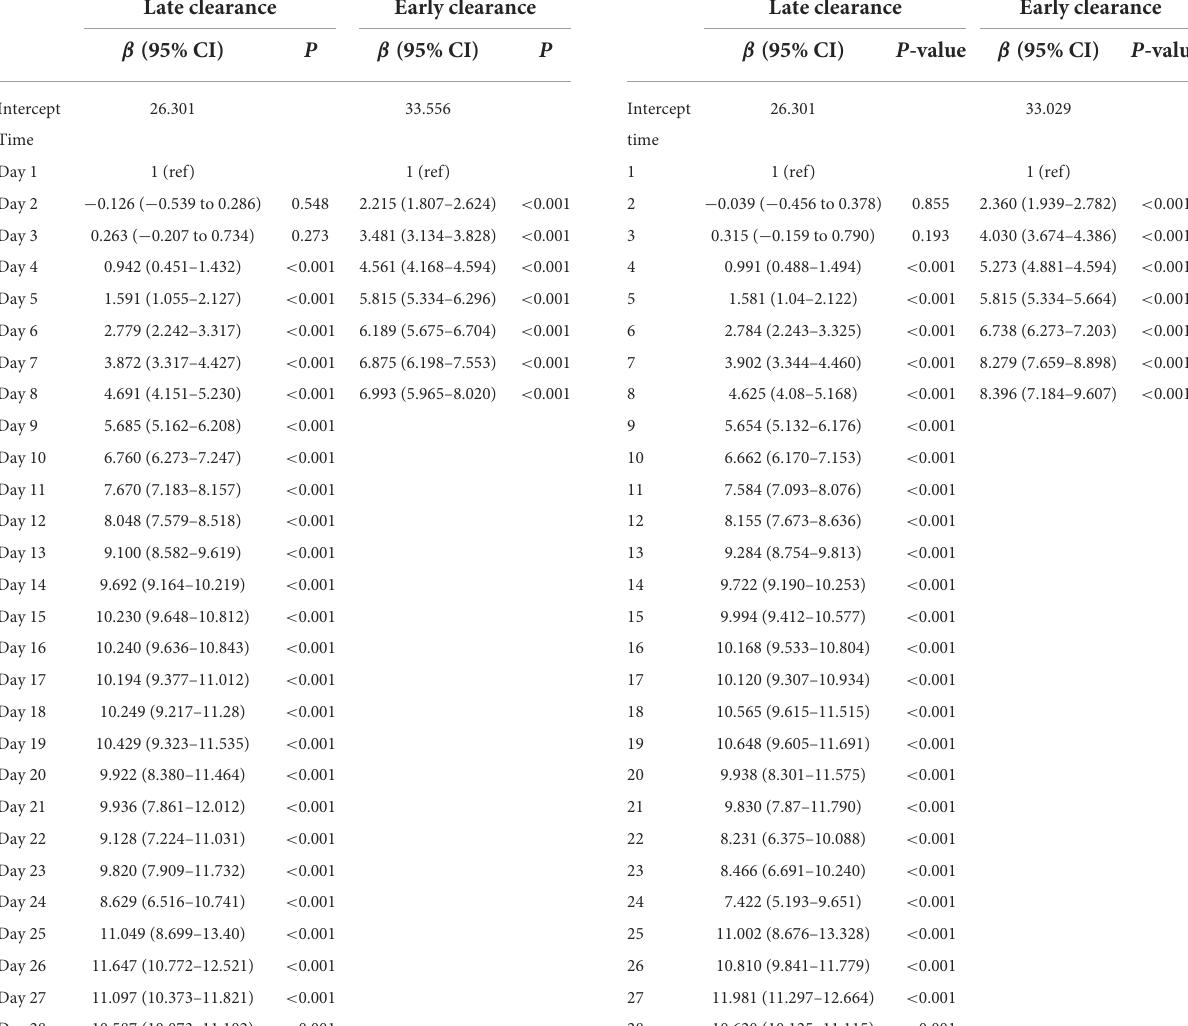
TABLE 7 Estimated factors associated with Ct values of ORF 1ab gene with times by GEE.